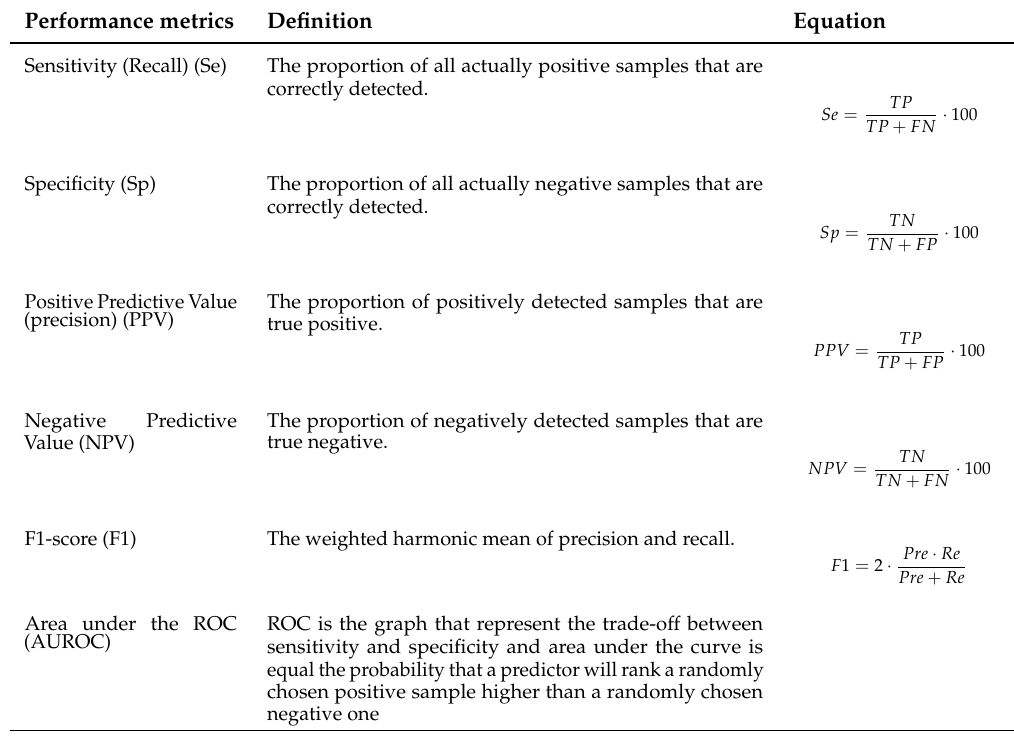
Table 5. List of evaluation metrics commonly used by phenotyping